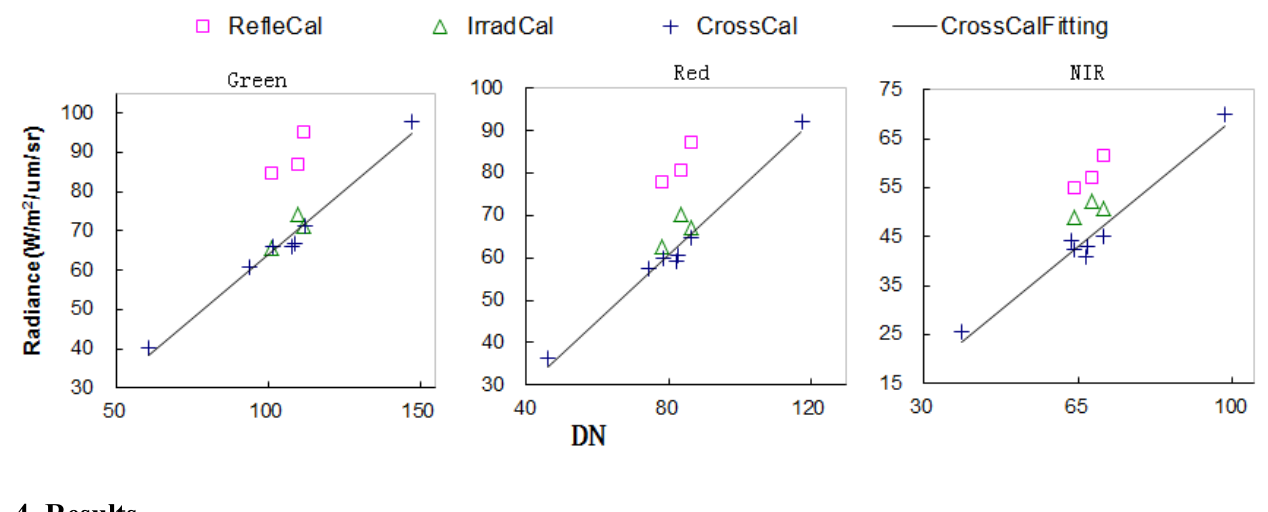
Figure 6. Plots of the DNs and corresponding top-of-atmosphere (TOA) radiance ( L calibrated via the three vicarious